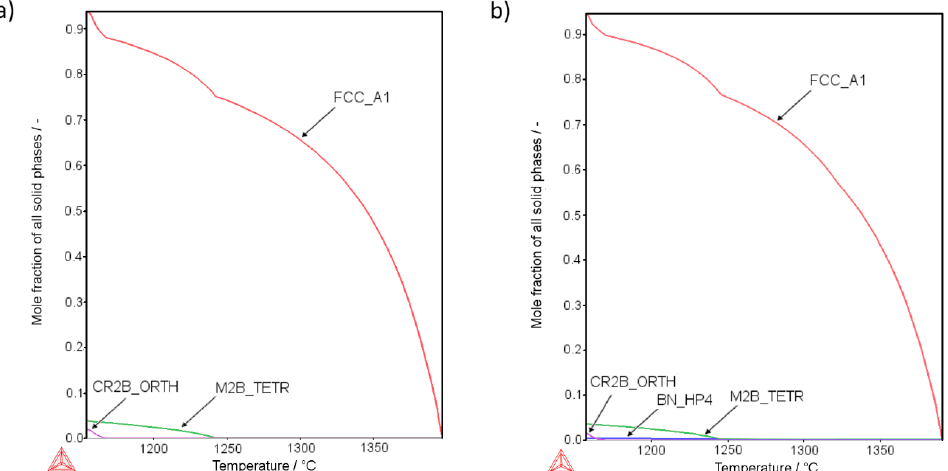
Figure 1. Scheil–Gulliver solidification plots of samples a ) 4-0 and b ) 4-8. Where: FCC_A1—Austenite, CR2B_ORTH—Orthorhombic (chromium, iron) boride, M2B_TETR—tetragonal (iron, chromium, molybdenum) boride, BN_HP4—Wurtzite-structured boron nitride.